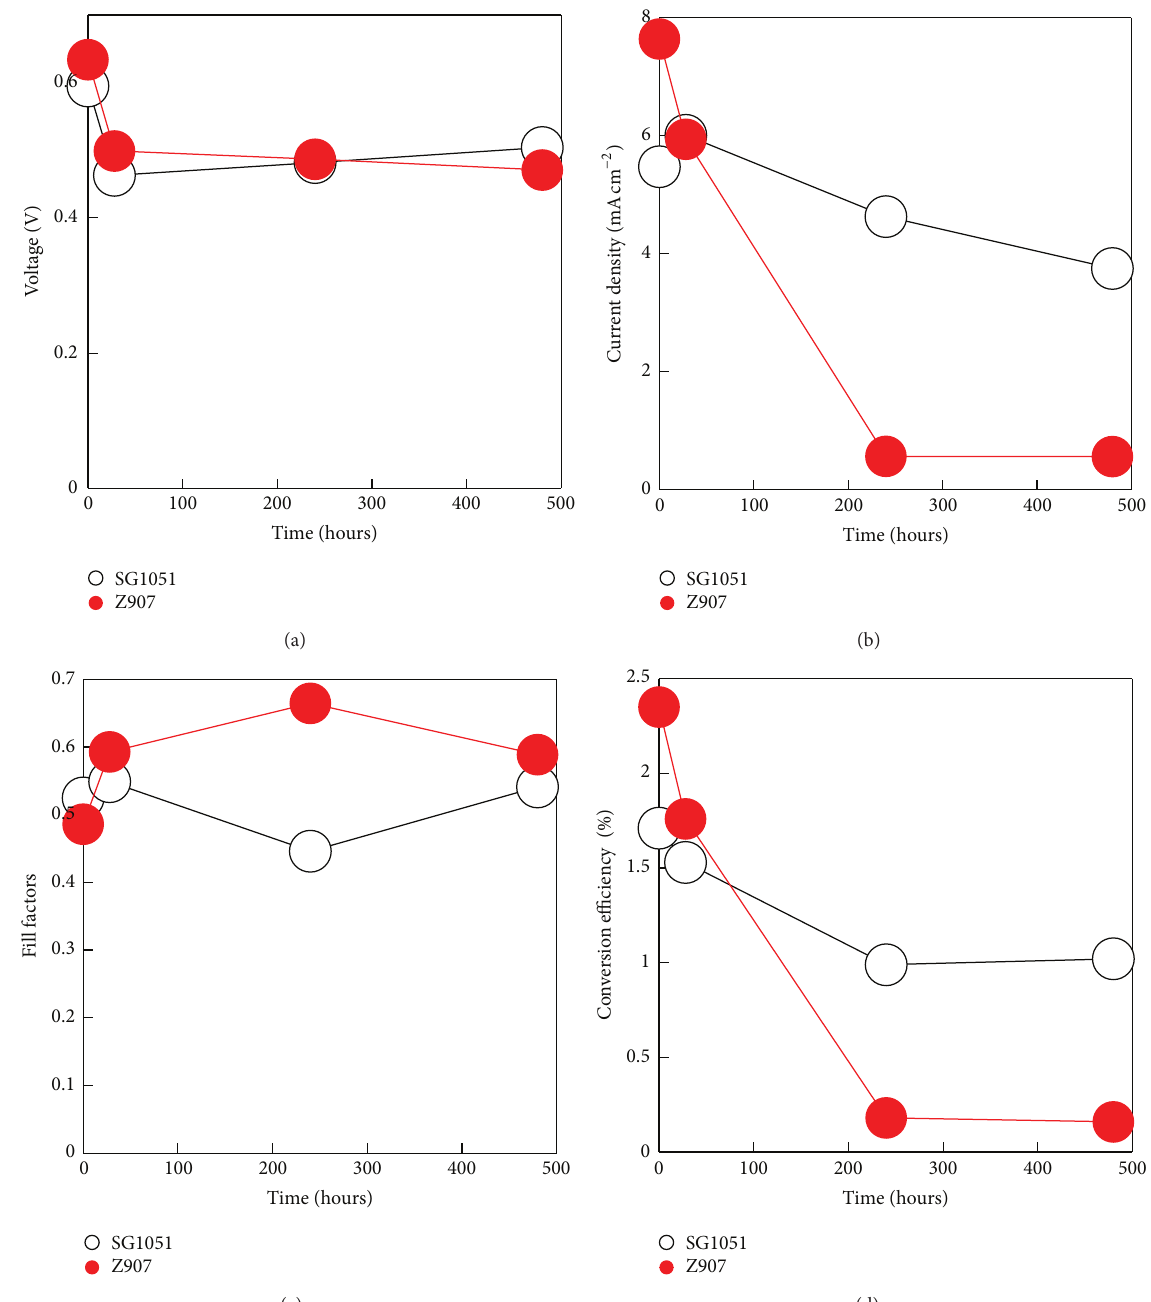
Figure 4: Variation of photovoltaic effects of dye-sensitized solar cells using ionic-liquid electrolyte and Z907 and double-bond-edged Ru dyes at 120 ∘ C: (a) open-circuit photovoltage, (b) short-circuit photocurrent density, (c) fill factor, and (d) conversion efficiency.